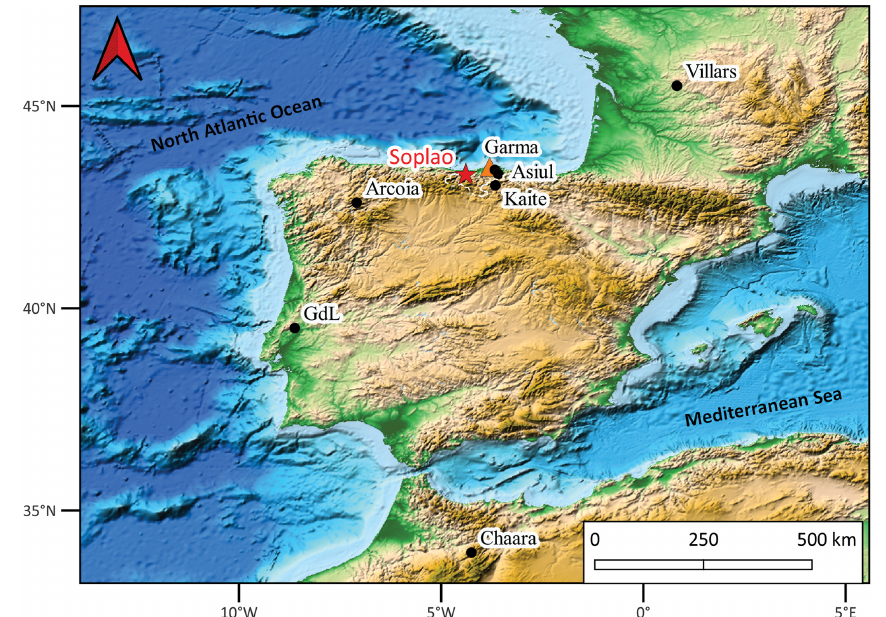
Figure 1. Location of the main palaeoclimate records discussed in the text: Soplao (El Soplao Cave; this study), Garma (La Garma Cave; Baldini et al., 2019), Kaite (Kaite Cave; Domínguez-Villar et al., 2009, 2017), GdL (Galeria das Lâminas; Benson et al., 2021), Chaara (Chaara Cave; Ait Brahim et al., 2019), Asiul (Cueva de Asiul; Smith et al., 2016), Arcoia (Cova da Arcoia; Railsback et al., 2011) and Villars (Villars Cave; Ruan, 2016). Location of the Santander GNIP station is indicated by an orange triangle. Meteorological data from the Cantabrian province (Rodríguez-Arévalo et al., 2011) are measured at various sites located between 42–43 ◦ N and 2–6 ◦ W (white, stapled line). Base map (ETOPO1 1 Arc-Minute Global Relief Model) collected from NOAA National Geophysical Data Center (2009) and map created in